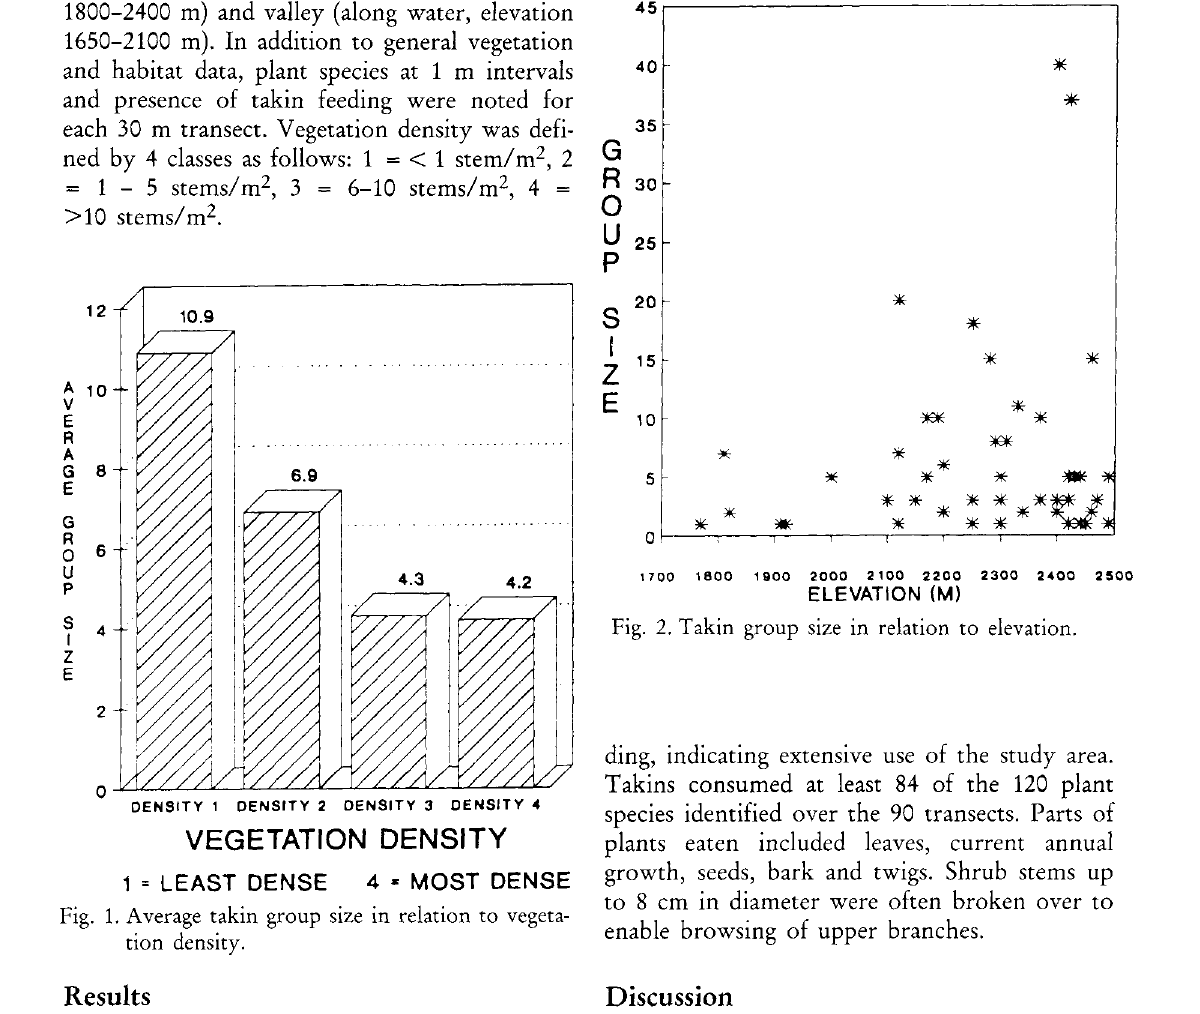
Fig. 1. Average takin group size in relation to vegeta tion density.